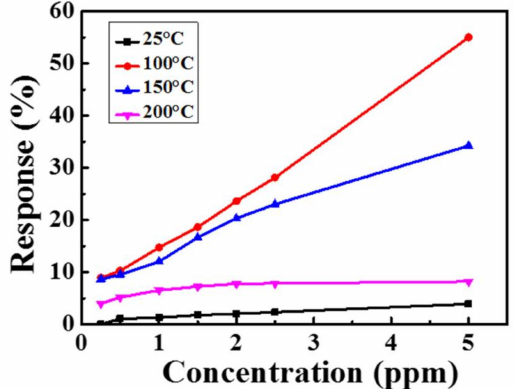
Figure 6. The response values of the sensor with various NO 2 concentrations at different operat- ing